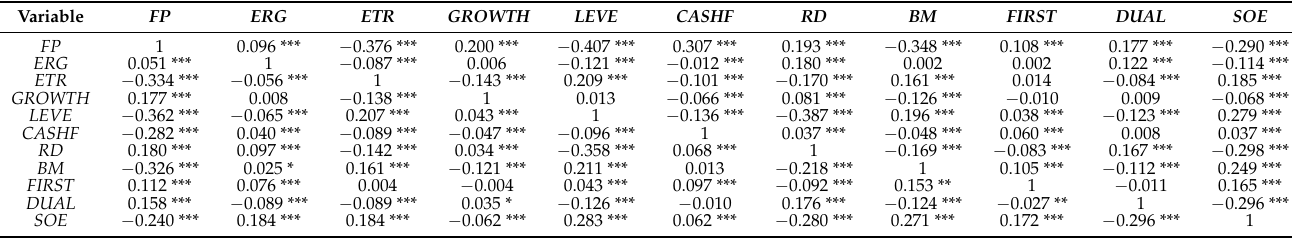
Table 3. Correlation coefficient matrix of variables.